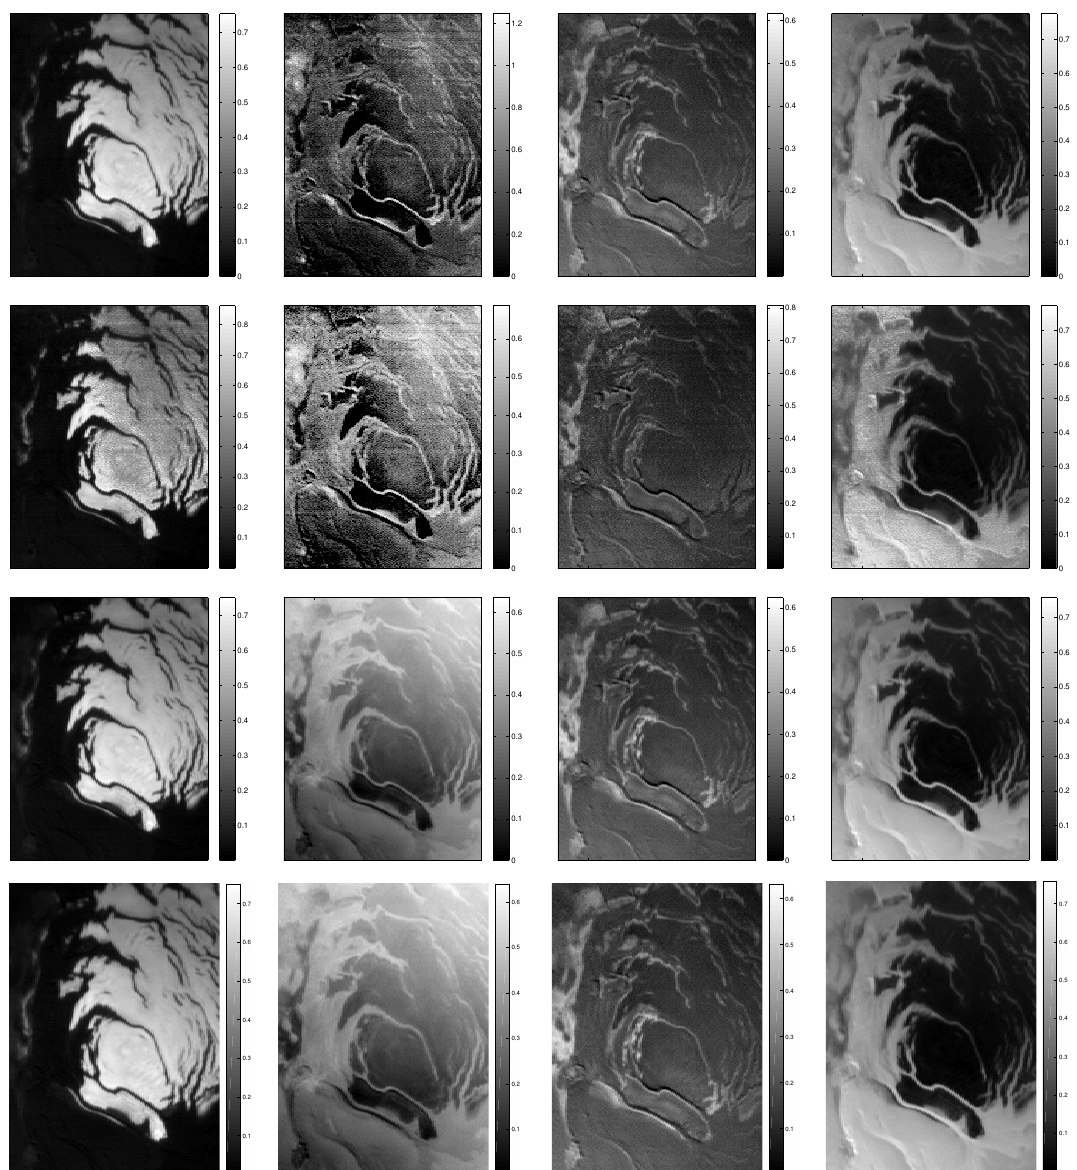
Figure 10. Abundance maps computed with the spectra of the endmembers extracted by SISAL. The abundances are, respectively, estimated by the use of NNLS (first row), normalized NNLS abundances by the use of Equation (13) (second row), FCLS (third row) and MLMp (fourth